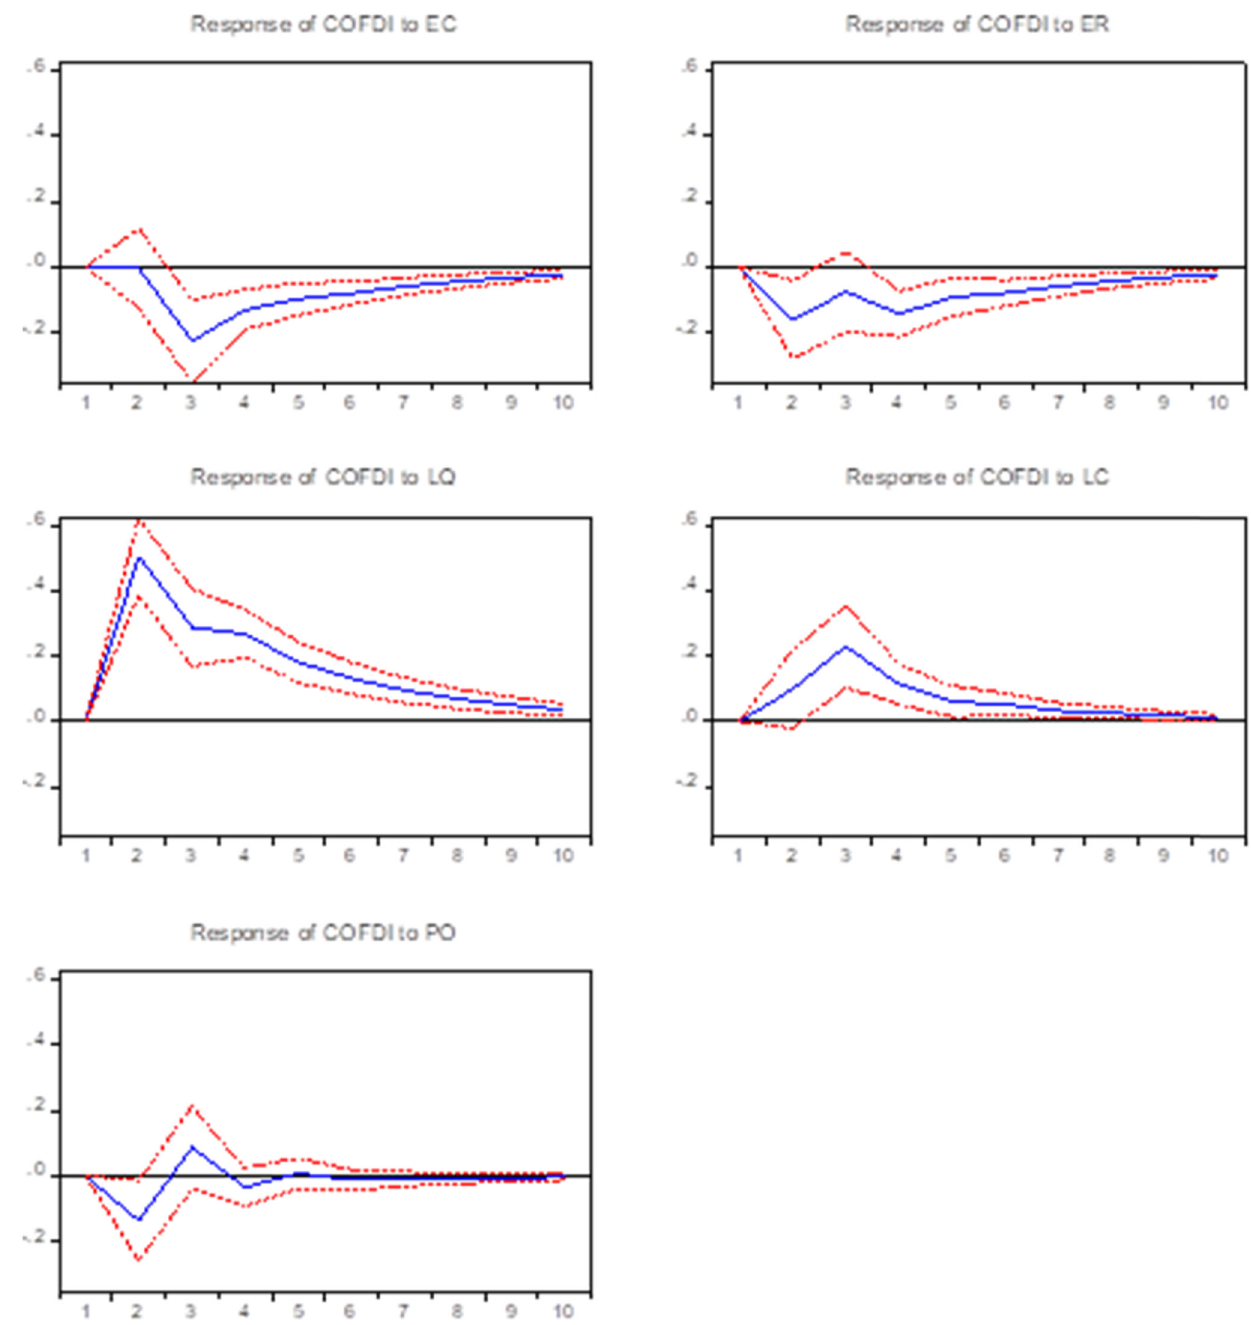
Fig. 2 Impulse response functions results for